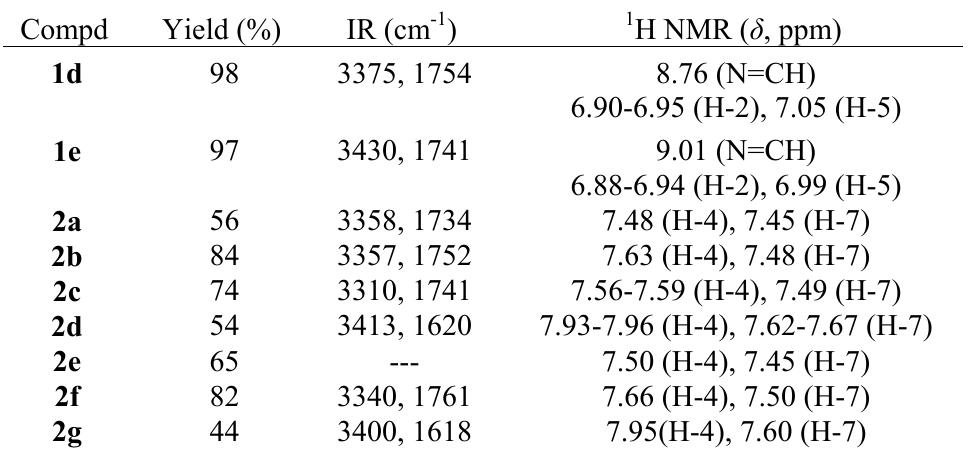
Table 1. Synthesis data of tyrosine derivatives 1d - e and alanine derivatives 2a - g